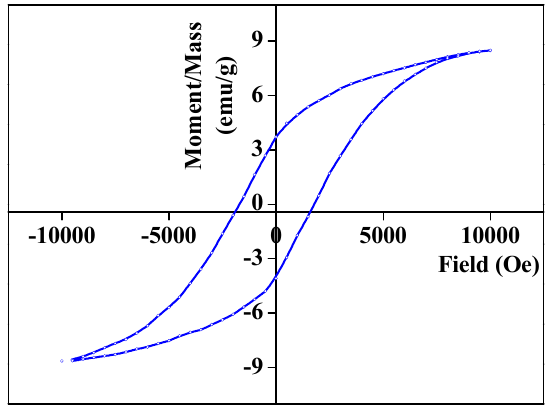
Figure 7: (a) TEM micrographs of CoFe pattern and (c) particle size distribution along with a Gaussian fitting curve.